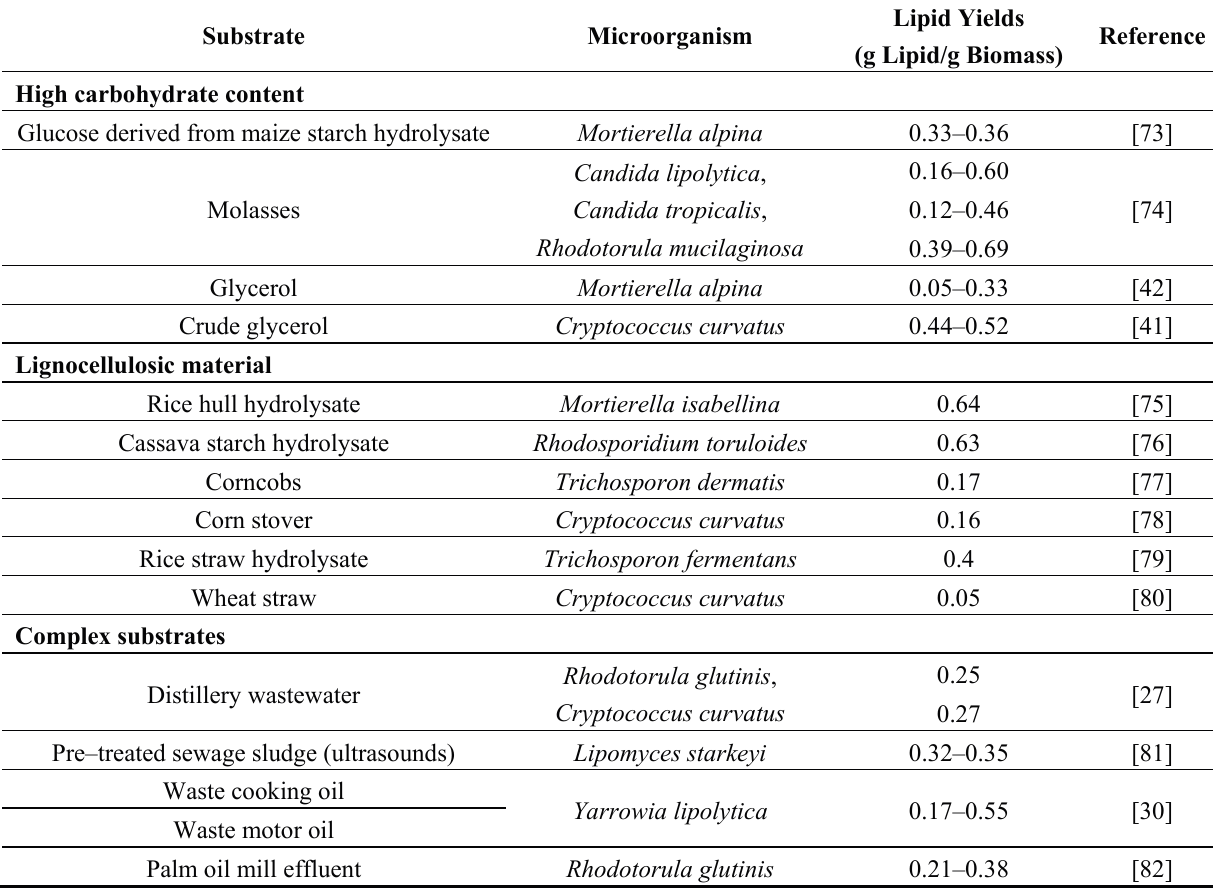
Table 2. Lipid yields reported in the literature from different wastes and lignocellulosic